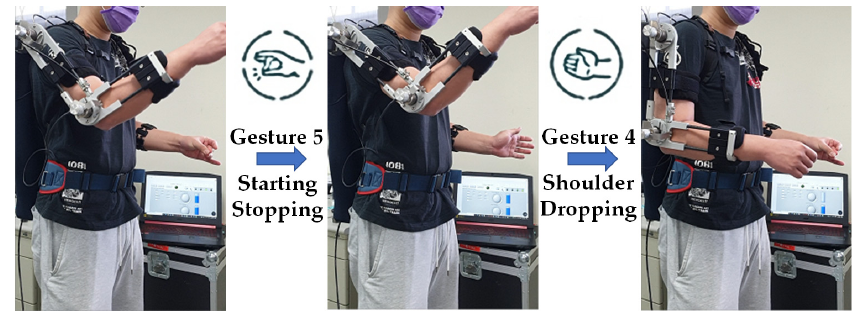
Figure 29. Basic action experiment for shoulder lifting.